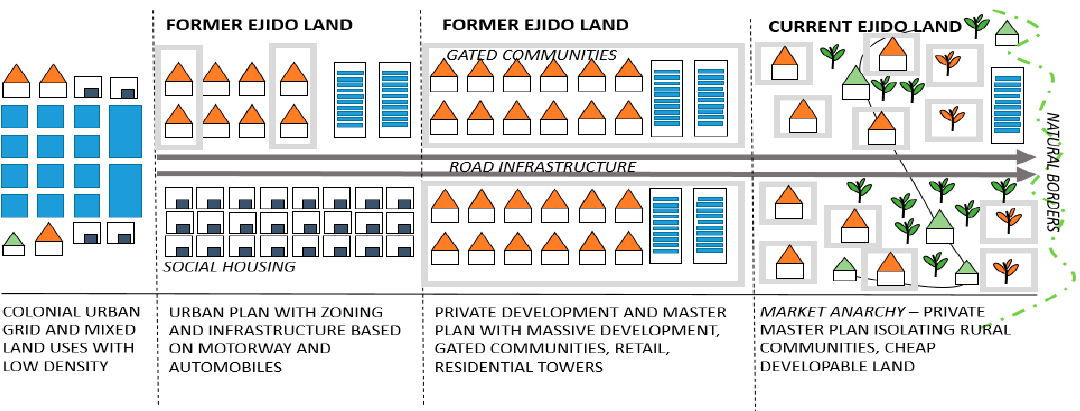
Figure 10. Segregation and urbanization model of former Ejido land. Source: Melissa Schumacher (2019).